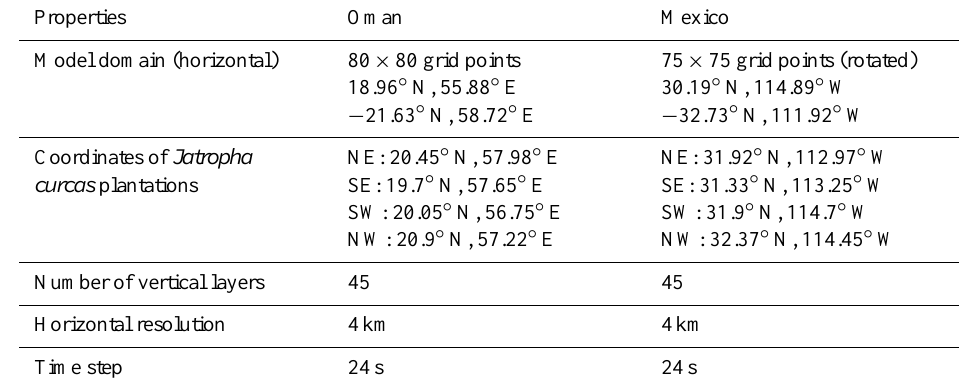
Table 3. Configuration of the WRF model.